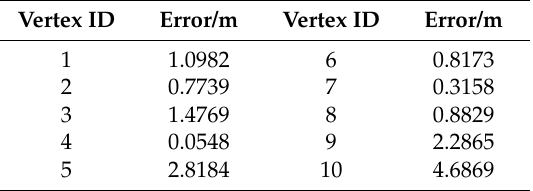
Table 4. Distance errors of vertex points in the constructed pathway